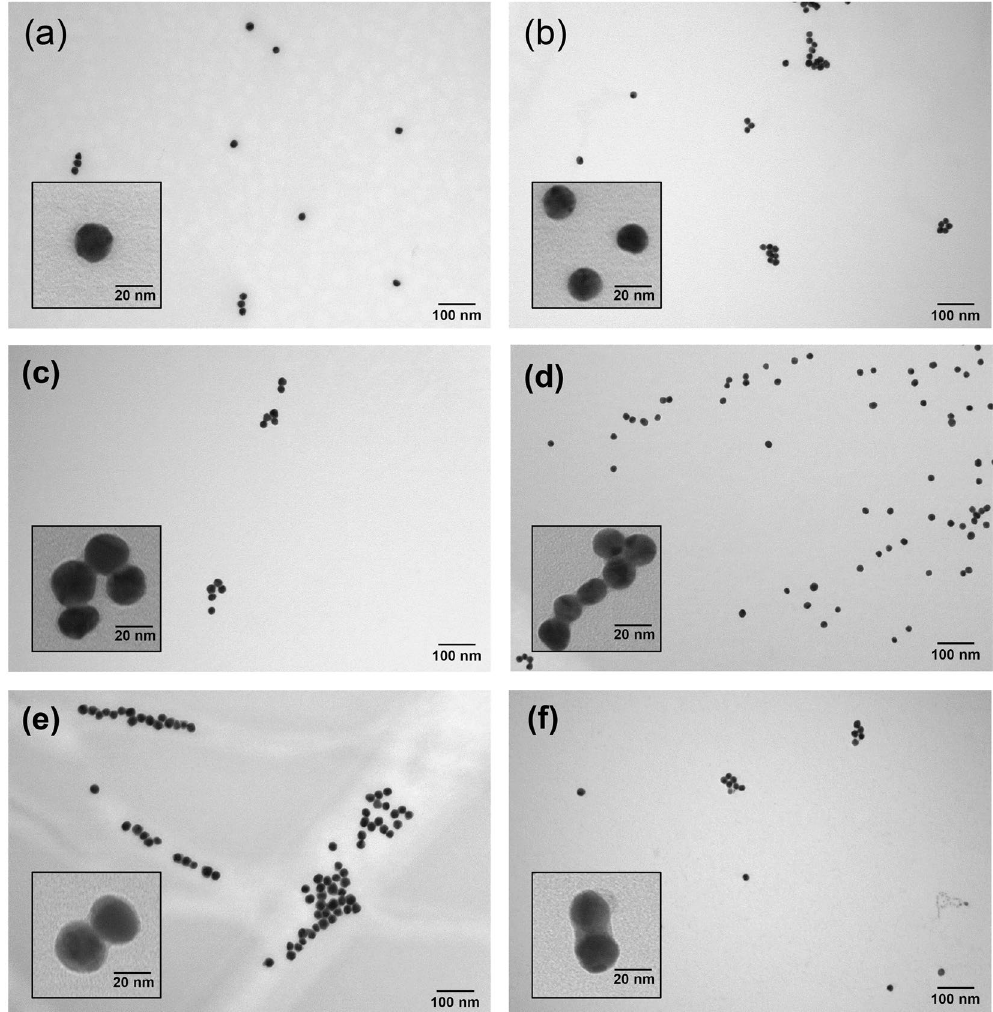
20 nm Au NPs, ( b ) 15 nm Au NPs, ( c ) 20 nm Au-Ag 1000/1 NPs, ( d ) 15 nm Au-Ag 1000/1 NPs, ( e ) 20 nm Au-Ag 100/1 NPs, and ( f ) 15 nm Au-Ag 100/1 NPs. The inset of each figure is a 750,000 × magnified image of the corresponding